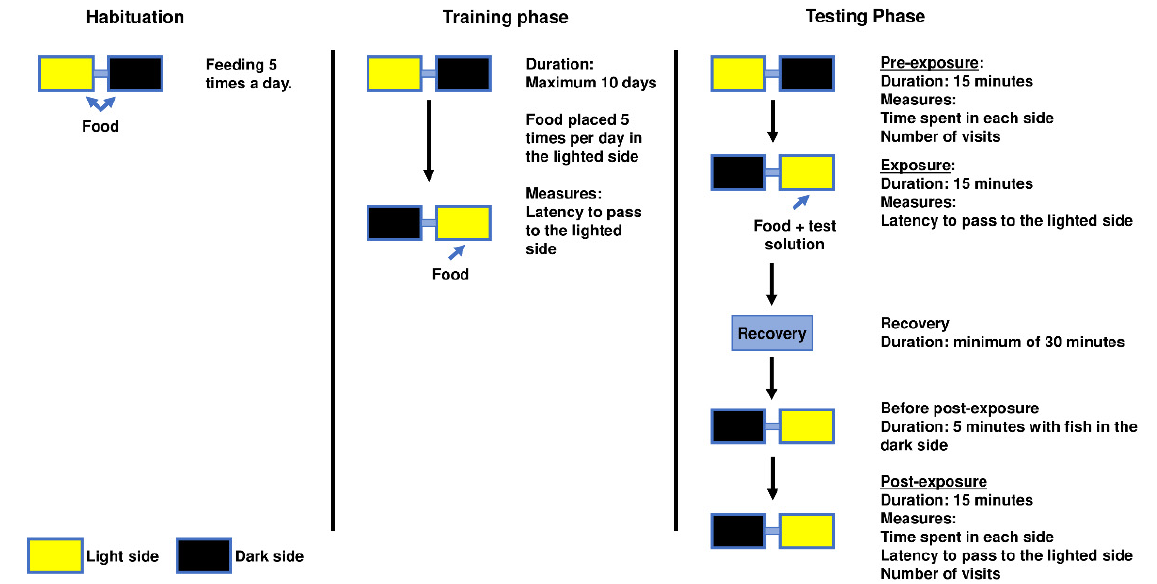
Figure 2. Conditioned place aversion behaviour test scheme with measurements taken in each phase. The habituation phase lasted for 48 h followed by a training phase in which the training baseline was established; training was completed when the criteria for fully trained animals was reached (see Section 2). Afterwards, the testing phase was divided into pre-exposure and post-exposure performed on the same day. Recovery represents the recovery of the anaesthesia or other testing solution when the animal was placed in clean water. Which tank was lighted at each given time and where the food and testing solutions were introduced are also depicted.